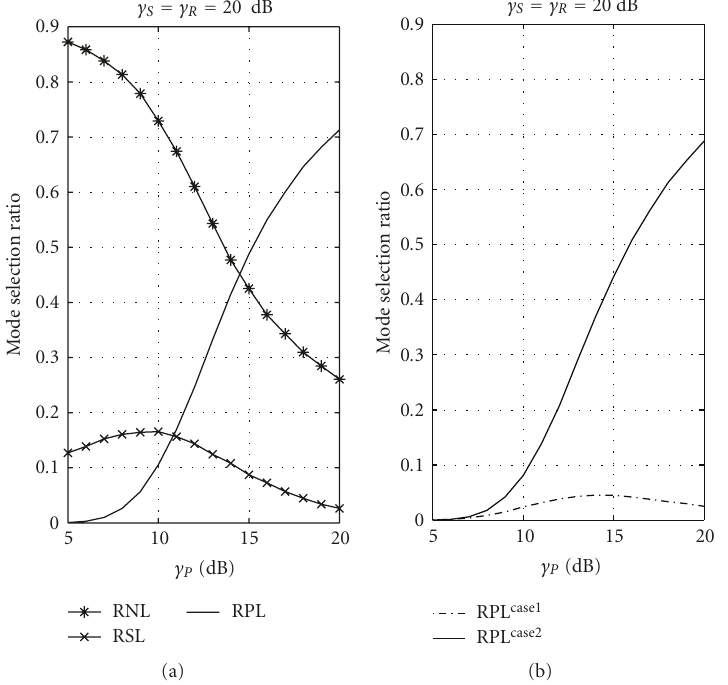
Figure 4: Transmission mode selection ratio.